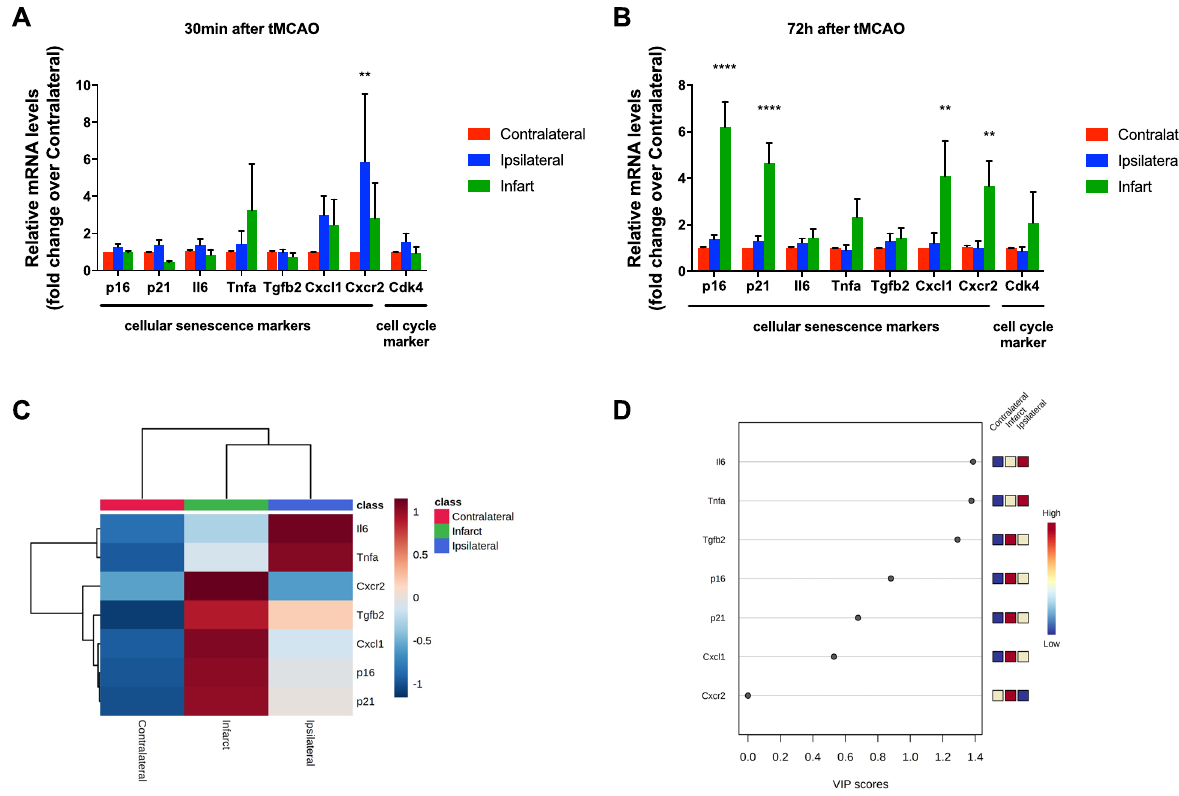
Figure 1. mRNA levels of a set of SASP and inflammatory markers. mRNA levels of a set of cellular senescence markers (fold change over contralateral) are increased and correlated in infarct core at 72 h after tMCAO. ( A ) qRT-PCR analyses of p16 , p21 , Il6 , Tnfa , Tgfb2, Cxcl1, Cxcr2 and Cdk4 comparing infarct, ipsilateral and contralateral regions of MCAO mouse model at 30 min after tMCAO. ( B ) qRT-PCR analyses of p16 , p21 , Il6 , Tnfa , Tgfb2, Cxcl1, Cxcr2 and Cdk4 comparing infarct, ipsilateral and contralateral regions of MCAO mouse model at 72 h after tMCAO. ( C ) Heatmap of analyzed regions, average sample expression. ( D ) Variable importance in projection (VIP)